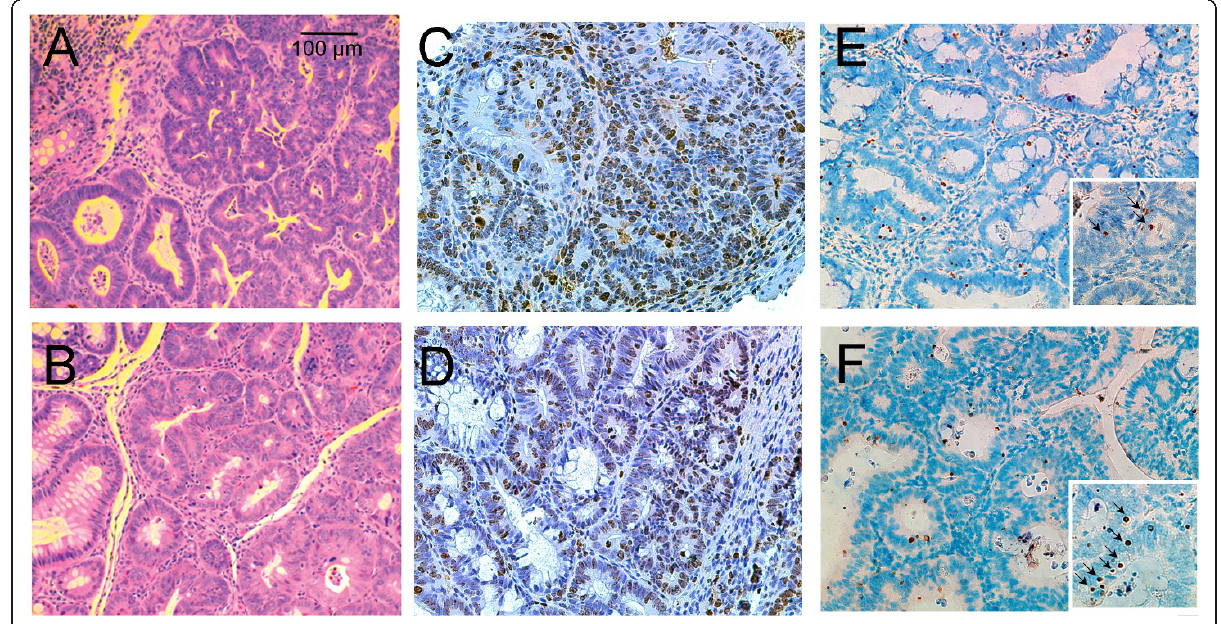
Figure 2 Ginseng reduces proliferation and increases apoptosis in AOM/DSS-induced tumors from mice fed a Western diet . A . H&E stained tumor from mouse on Western diet alone; (20×); B . H&E stained tumor from mouse on Western diet supplemented with 250 ppm Wisconsin ginseng extract (20×); C . Ki67 in tumor from WD fed mouse, (20 x); D . Ki67 in tumor from mouse on WD plus ginseng (20×). Note the increased brown staining (Ki67 positive nuclei) in C compared to D; E . TUNEL staining in tumor from WD fed mouse (20×); F . TUNEL staining in tumor from mouse on WD plus ginseng (20×). Inset 40× magnification. Note the increased apoptotic bodies indicated by black arrows in F compared to E.